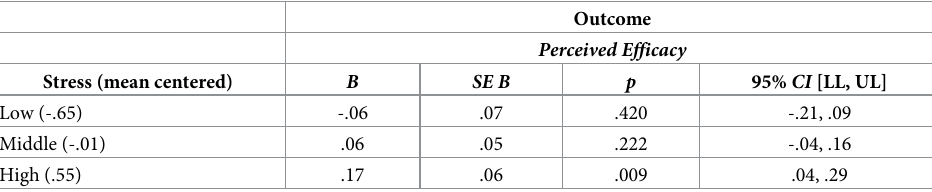
Table 3. Conditional effects of experienced shift on perceived efficacy by